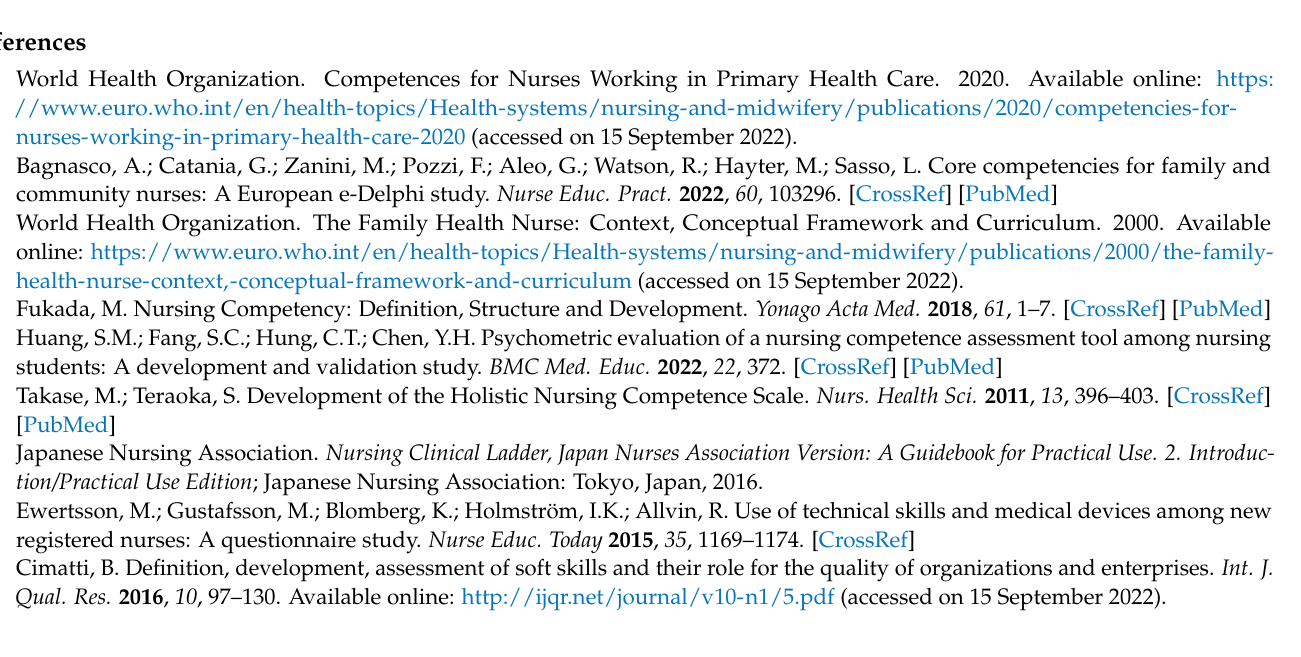
Table S2: Internal consistency of used questionnaires; Table S3: Descriptive statistics of surveyed respondents ( n = 446); Table S4: Influence of selected variables on the level of social competences of the surveyed nurses; Table S5: Association between sociodemographic features, Empathic Under- standing Questionnaire, Type D personality and subscales PROKOS Questionnaire—Part 1; Table S6: Association between sociodemographic features, Empathic Understanding Questionnaire, Type D personality and subscales PROKOS Questionnaire—Part